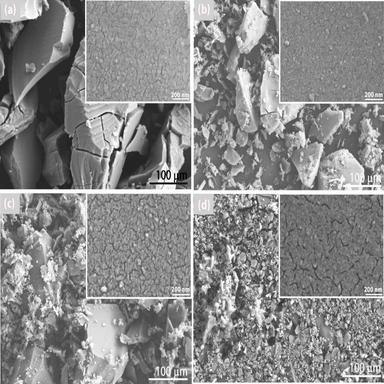
FE-SEM micrographs of F-doped SiOC-DC materials pyrolyzed and etched under different conditions: (a) TRP11F1, (b) TRP11F24, (c) TRP14F1 and (d) TRP14F24, respectively.